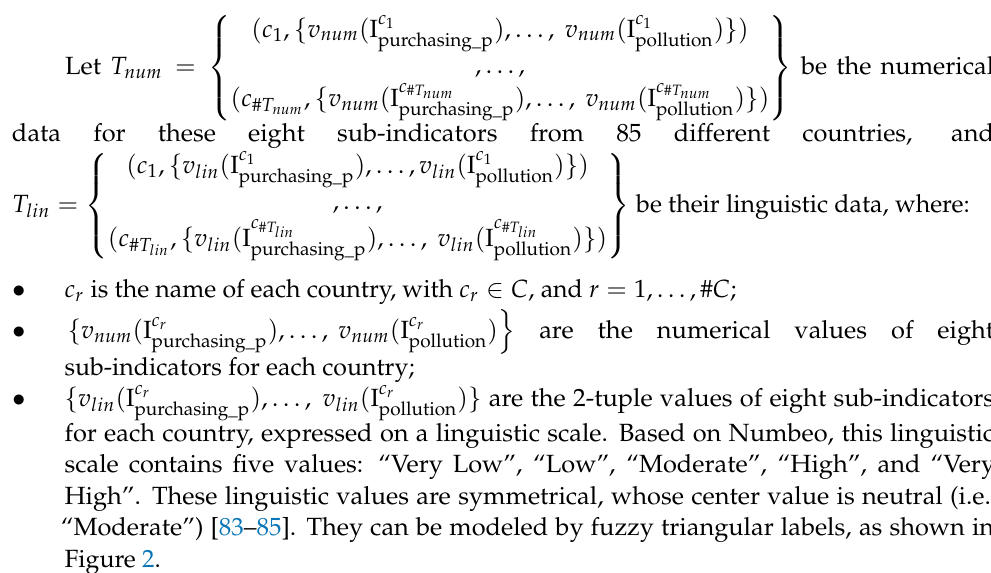
Figure 5. Example of quality of life data in Canada in the Numbeo database.